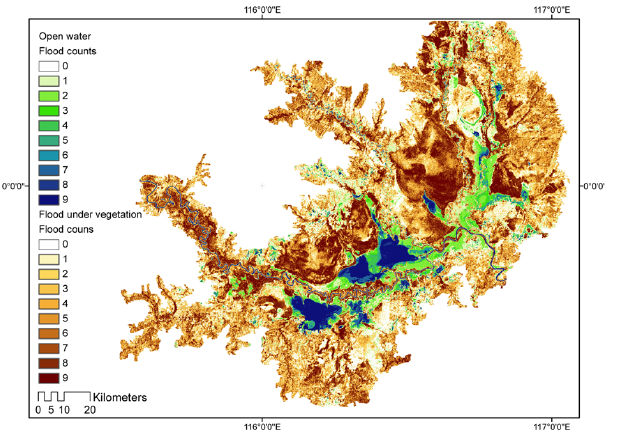
Fig. 15. Composite flood occurrence map of the Kutai wet- lands from nine PALSAR images collected in 2008 and 2009 as an overlay of results for open water and for inundation under vegetation cover.